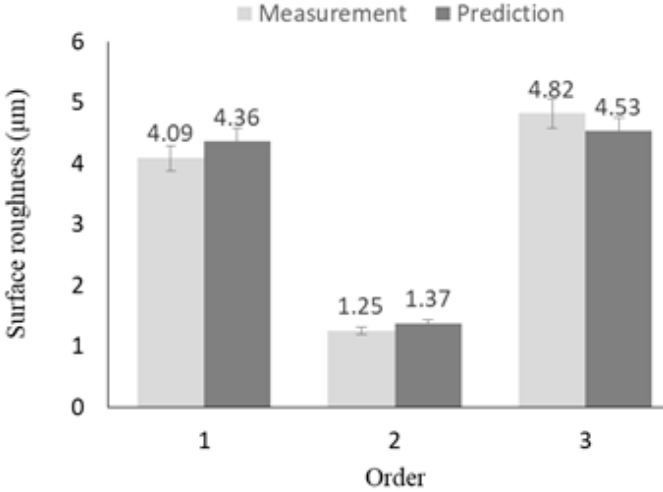
Figure 9. The comparison of the cutting force between the prediction equation results and the confirmation experiment results.